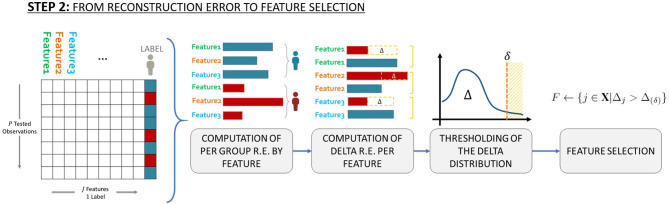
Schematic representation of the workflow used to identify which features to select to characterize the minority class (i.e., patients with toxicity) with respect to the majority class (patients without toxicity).